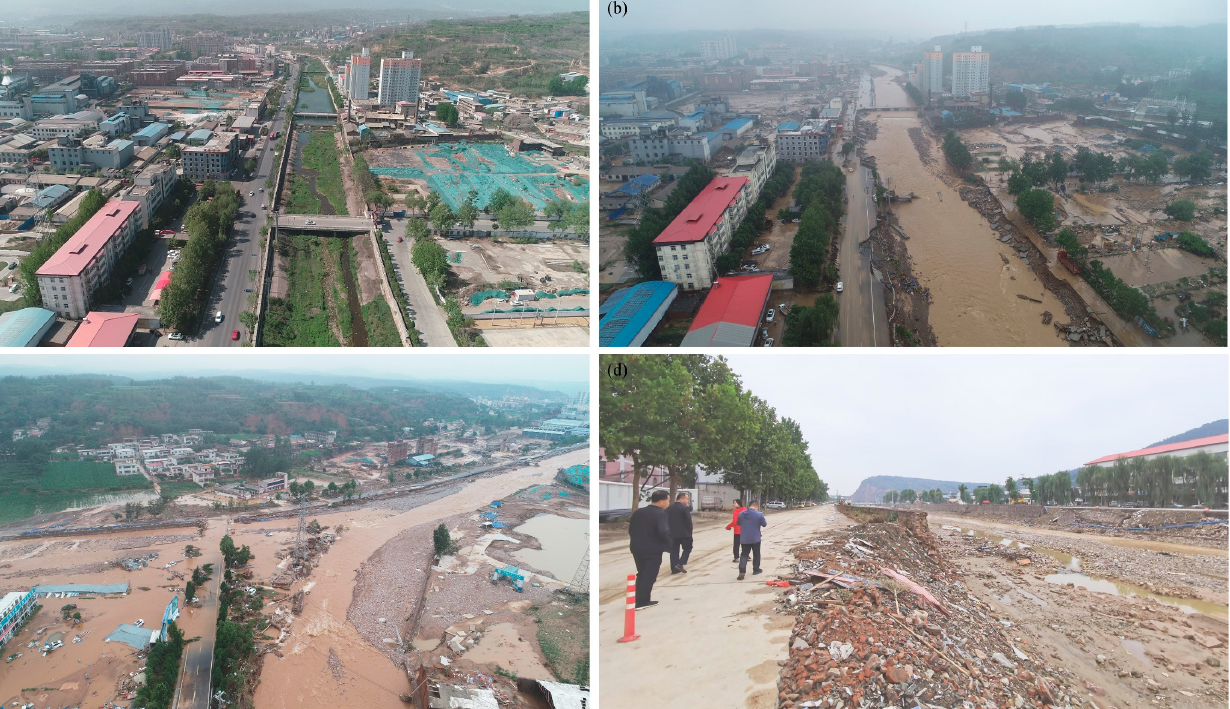
Figure 6. Scenes from Mihe Town before, during, and after the “7·20” flood disaster. ( a ) The core region of Mihe Town before the disaster; ( b ) The core region of Mihe Town during the disaster; ( c ) Damaged road and buildings at the river confluence; ( d ) Damaged riverbank after the disaster. (Source: Turenscape Urban Planning and Design Co., Ltd.)